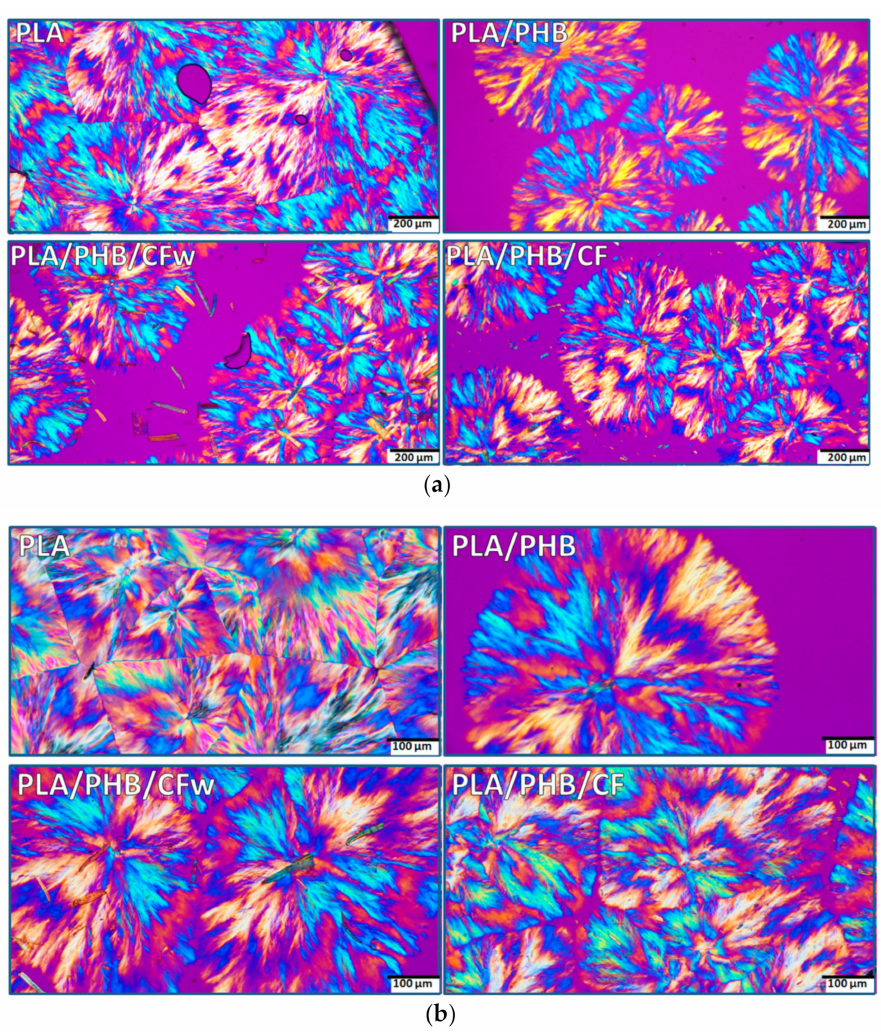
Figure 5. Polarized optical micrographs (different magnification) of isothermally crystallized PLA, PLA/PHB, and biocomposites at 130 ◦ C for 24 h: ( a ) × 10; ( b ) ×